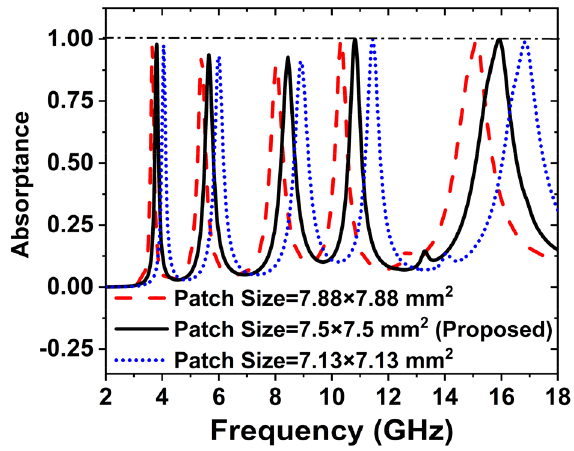
Figure 18. Effect of size of the patch on the absorption peaks and resonance frequency.